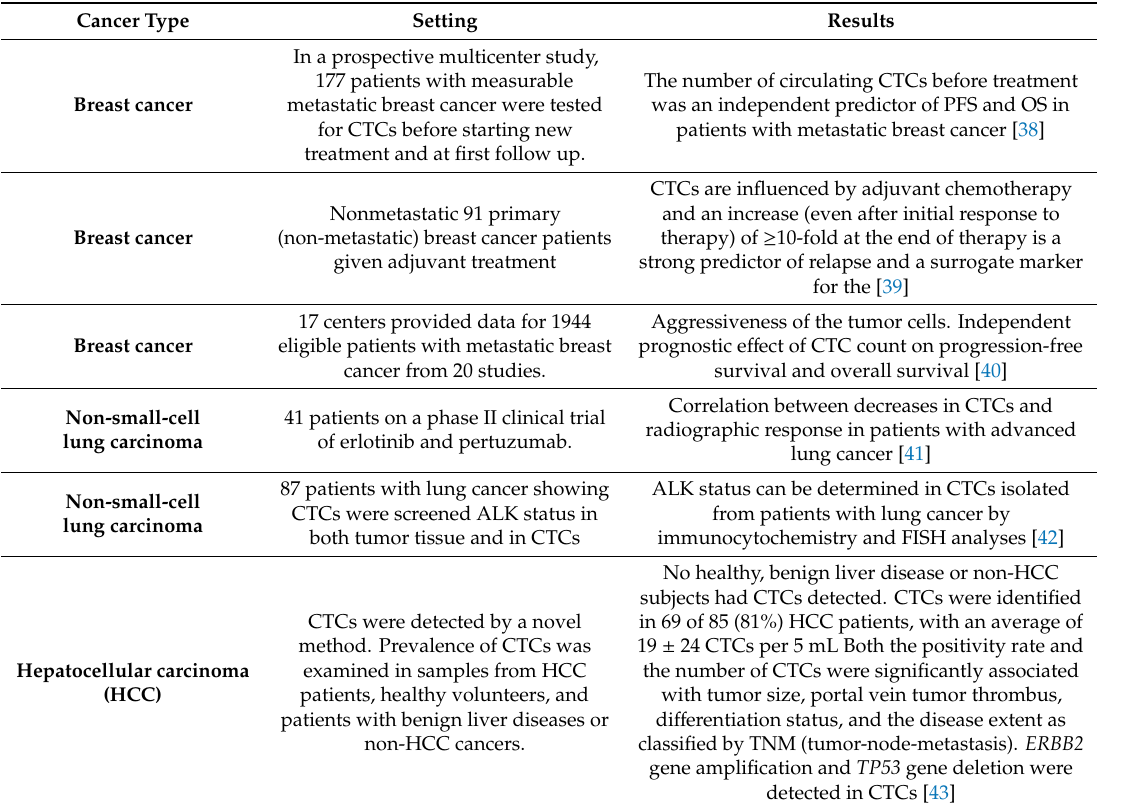
Table 2. Examples of the clinical utility of CTC detection